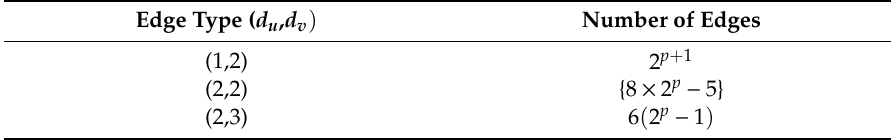
Table 3. Edge partition of nanostar polypropylenimine octaamin